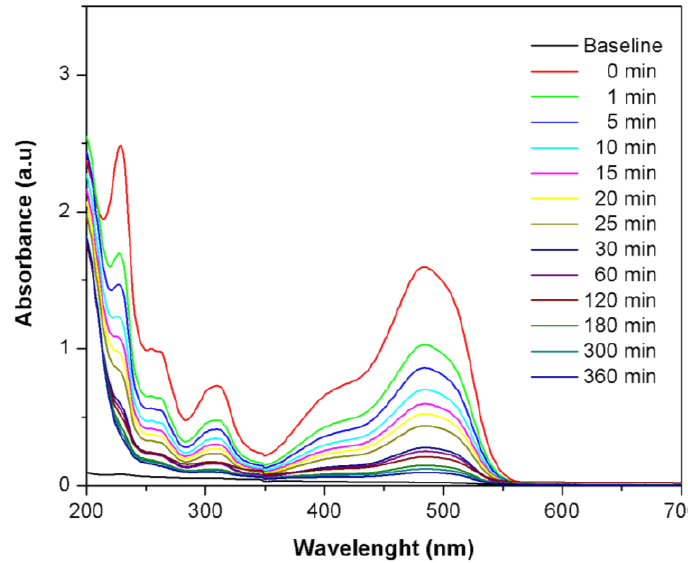
Figure 6. UV-Vis spectra of the adsorption of Orange II dye over Fe(BTC) at different times (initial concentration: 25 mg·L −1 ; adsorbent mass: 10 mg; temperature: 308 K; pH